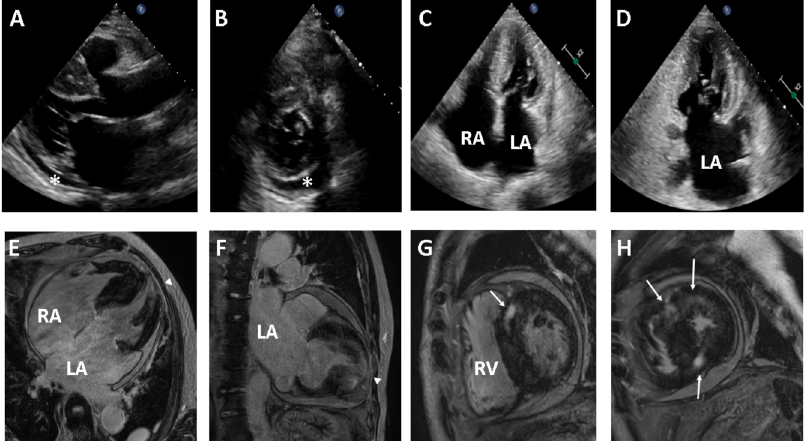
Figure 1. Transthoracic echocardiography (TTE) (upper panel) and contrast-enhanced cardiac mag- netic resonance (CMR) images (lower panel) from the proband with idiopathic restrictive cardiomy- opathy. Two-dimensional TTE reveals a normal left ventricle chamber ( A ), small pericardial effusion (asterisk) ( B ), and biatrial enlargement ( C , D ). CMR images demonstrate biatrial enlargement and transmural late gadolinium enhancement (LGE) in the apical wall (arrowhead) ( E , F ) and mid my- ocardial patchy LGE in the ventricular septum (arrow) ( G , H ). LA, left atrium; RA, right atrium; RV, right